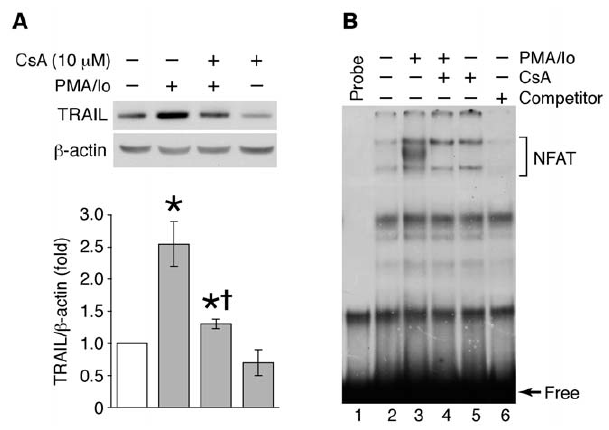
Figure 1. PMA/Io-mediated induction of TRAIL expression was attenuated by cyclosporin A, a potent calcineurin inhibitor in HT29 cells. ( A ) HT29 cells were pre-treated with cyclosporin A (CsA) for 30 min followed by the combination of PMA (100 nM) plus Io (2.5 m M) with CsA for 2 h. Total protein was extracted from cells and resolved by SDS-PAGE, transferred to a PVDF membrane and probed with anti-TRAIL and anti- b -actin antibodies. TRAIL signals from three separate experiments were quantitated densitometrically and ex- pressed as fold-change with respect to b -actin. (Data shown as mean 6 standard error of the mean; *, P , 0.05, PMA/Io or PMA/Io plus CSA vs. control; + , P , 0.05, PMA/Io plus CSA vs. PMA/Io). ( B ) Cells were treated with PMA/Io for 60 min in the presence or absence of CsA. Nuclear protein was extracted and NFAT DNA binding was analyzed by EMSA. Unlabeled NFAT oligonucleotide was added in molar excess to confirm binding specificity ( competitor ).